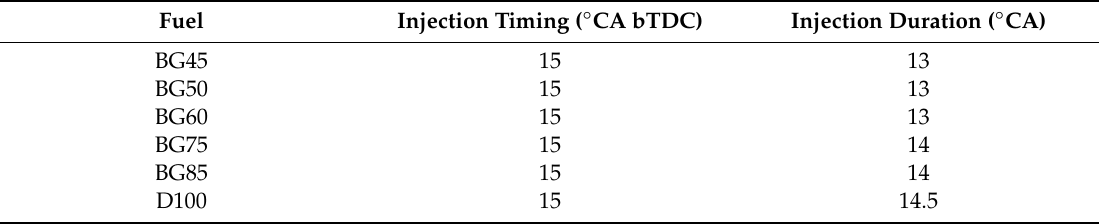
Table 4. Combustion parameters of diesel and biogas-diesel dual fuel